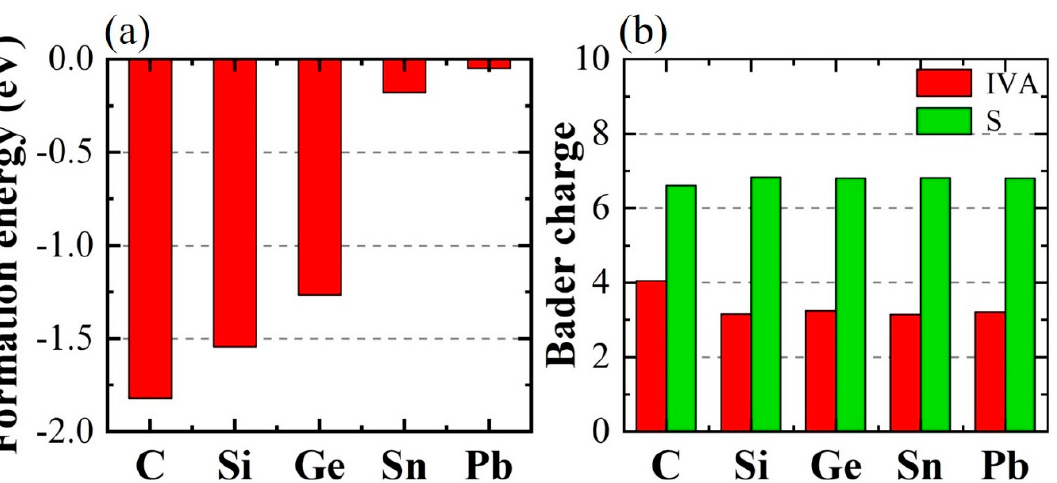
Figure 3. ( a ) Formation energies and ( b ) Bader charge of group − IVA element − doped the ZnS monolayer.